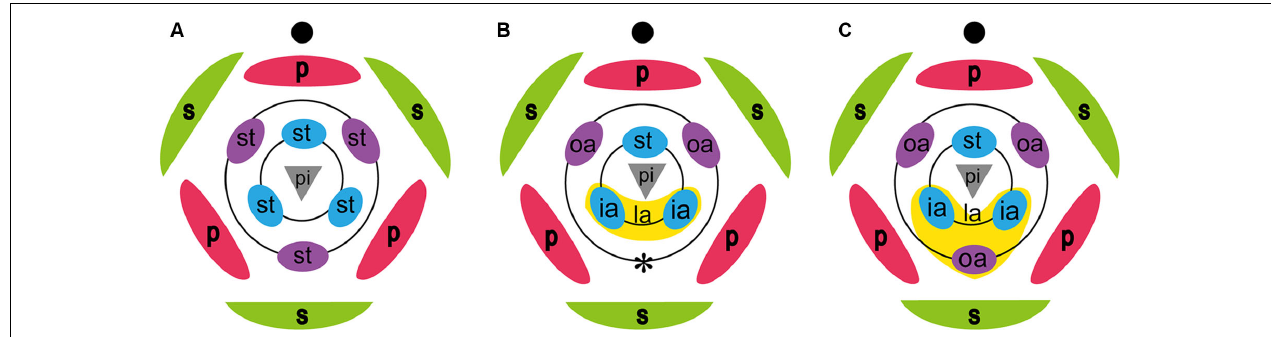
FIGURE 1 | Floral diagrams of a generalized monocot, Zingiberaceae, and possible floral diagram of Hemiorchis and Gagnepainia. (A) Representative monocot. (B) Zingiberaceae. The labellum is composed of two inner staminodes (ia), and the abaxial outer stamen is lost (*). (C) Possible floral diagram of Hemiorchis and Gagnepainia. The labellum is composed of three staminodes, two inner staminodes, and the abaxial outer stamen (oa). ia, inner androecial element (staminode); oa, outer androecial element (staminode); pi; pistil; s, sepal; st, stamen. Black circle in each figure indicates the main axis.